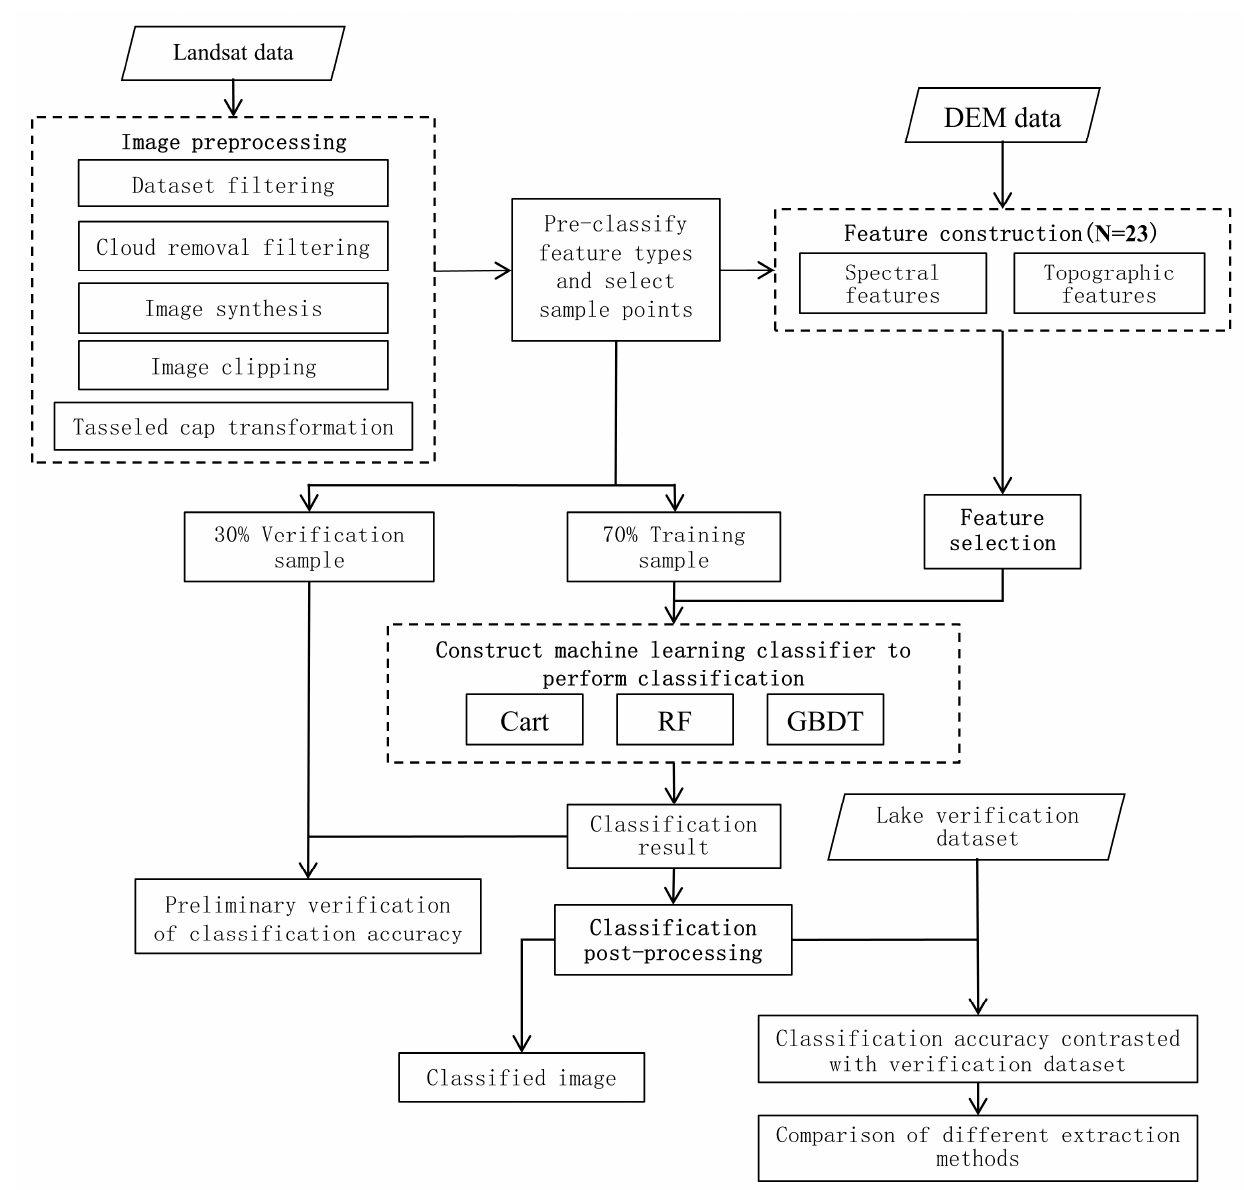
Figure 2. Lake extraction flow chart.